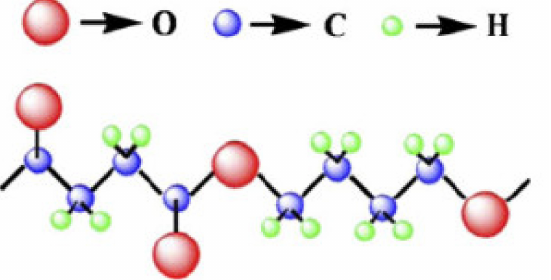
Figure 2. Chemical structure of poly butylene succinate [42]. Adapted with permission from AKanemura et al.